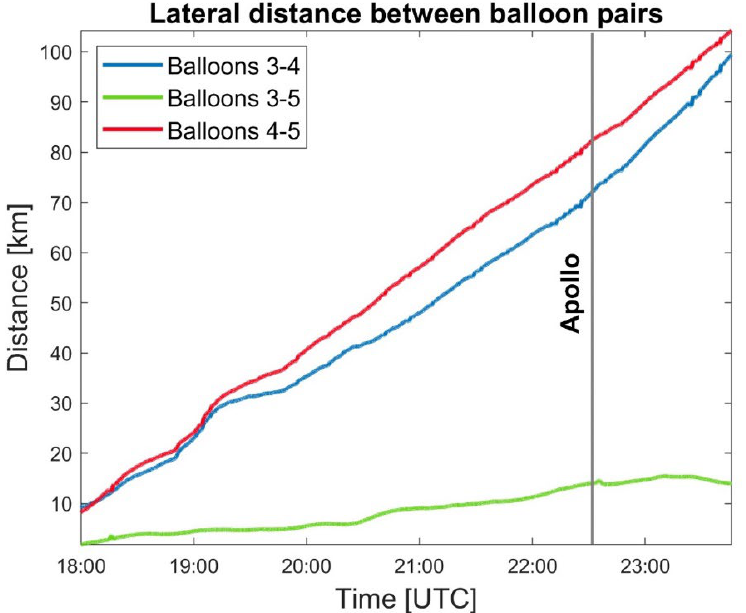
Figure 4. Lateral separations between the balloon pairs as a function of time, from 18:00 UTC to 23:59 UTC. The time of detonation is denoted with the vertical line. We note that the plot includes only the natural buoyancy phase of the balloon flight (the ascent and descent phases have not been plotted).